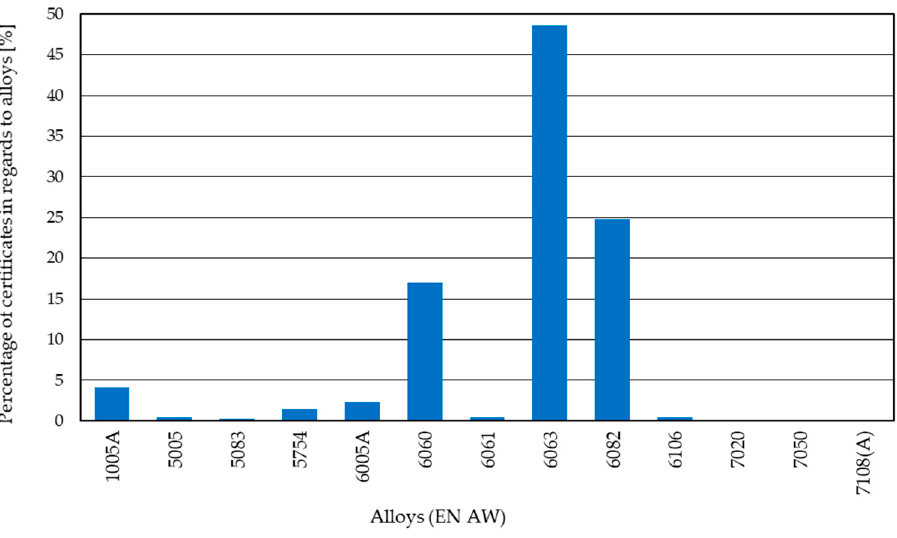
Figure 4. Distribution of obtained material test certificates (tensile test results) by alloys.